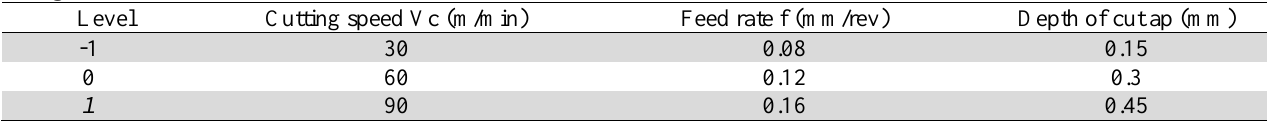
Assignment for the levels to the factors